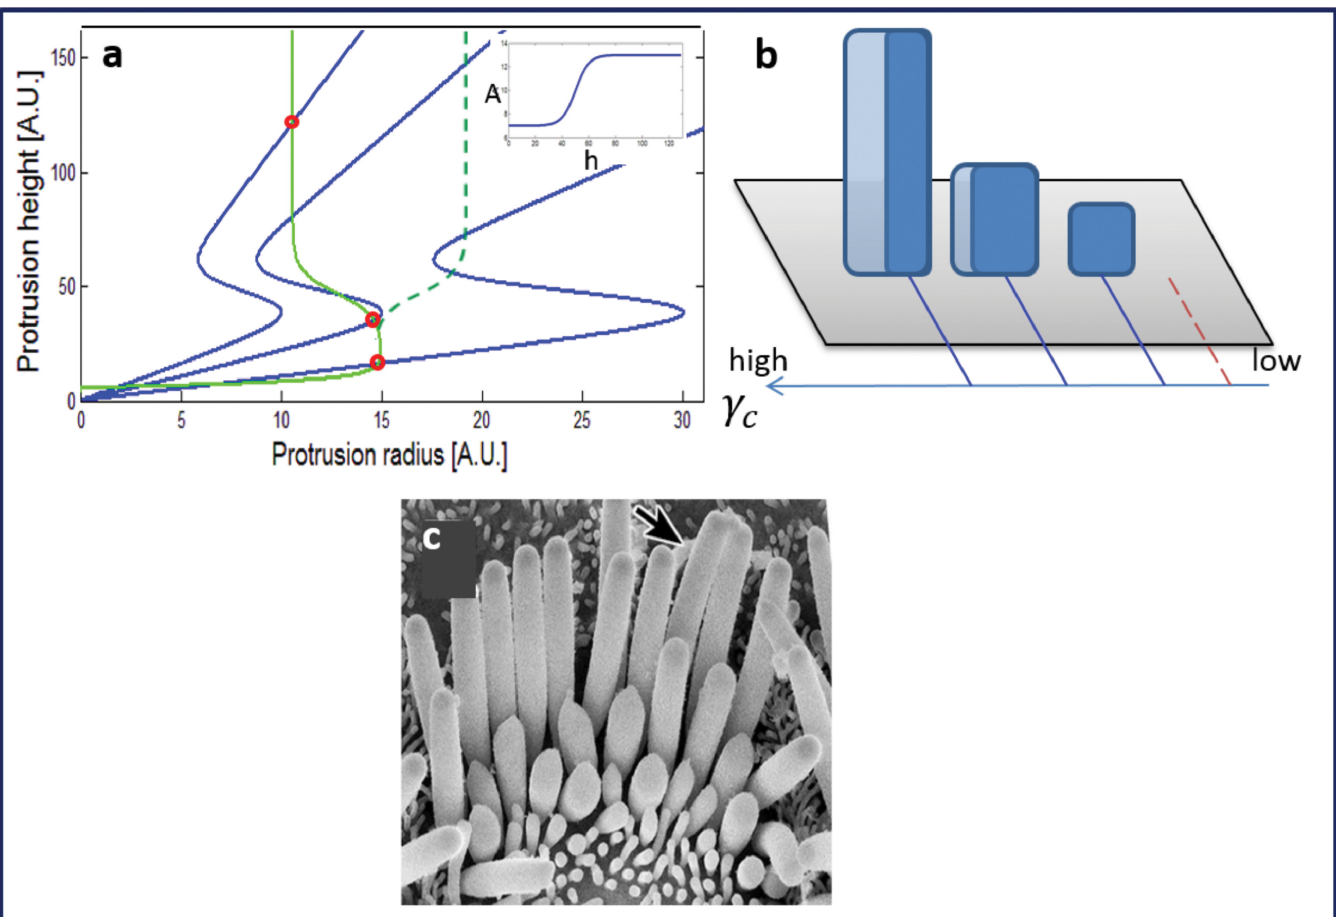
Fig 4. (a) Calculated heights and radii using the theoretical model, with the St.St solutions indicated by the red circles. Here we take a linear spatial gradient in γ c , and a polymerization rates A ( h ) that increases sharply with height (as shown in the inset). We get a staircase structure (b) a large jump in height for the first (tallest) row. This row may be either thinner or thicker than the other rows [2], as indicated by the solid green line (a) and dark blue shade in (b) and dashed green line (a) and the light blue shade (b) respectively. This result from the model compares well with the stereocilia bundle of the mammalian inner- hair cell (c) [26] (Sekerková G et al. (2011) Roles of the espin actin-bundling proteins in the morphogenesis and stabilization of hair cell stereocilia revealed in CBA/CaJ congenic jerker mice. PLoS Genet, 7(3),